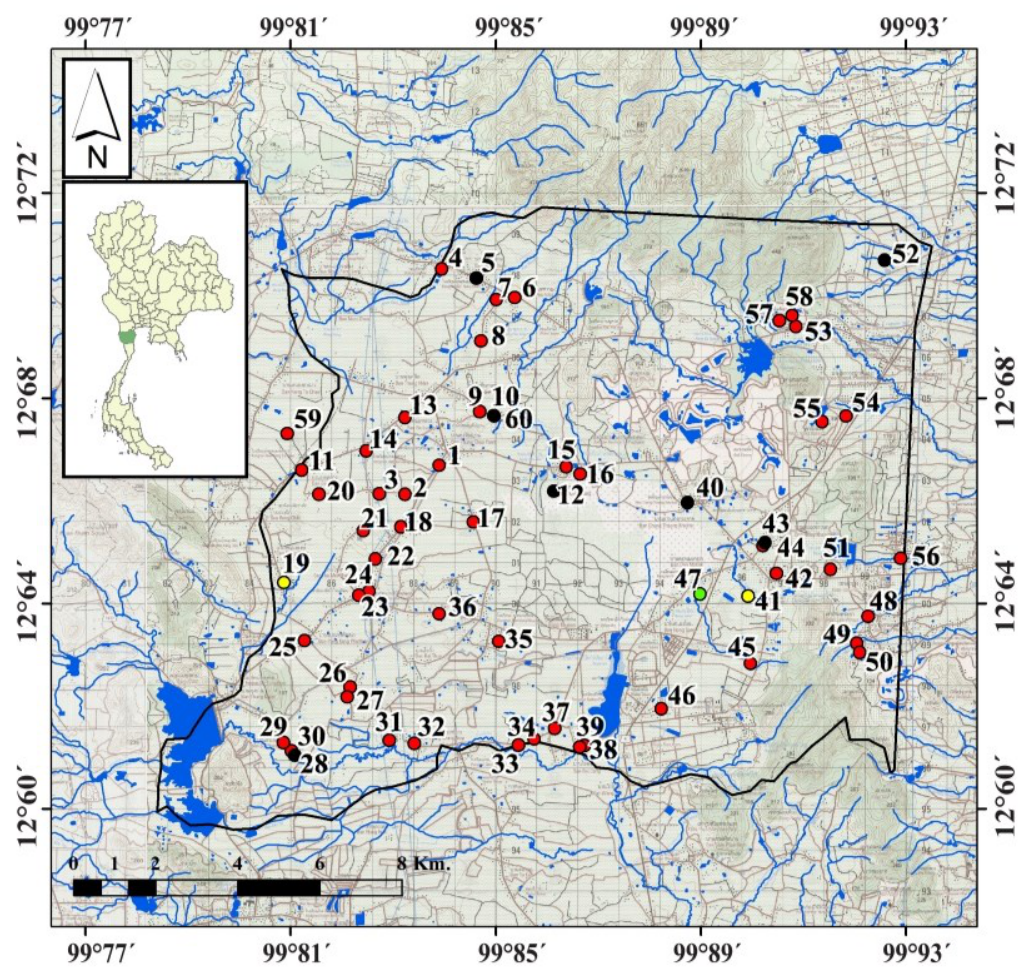
Figure 8. Locations of groundwater wells that were distributed by HCA; red points are HCA1, yellow points are HCA2, black points are HCA3 and green point is